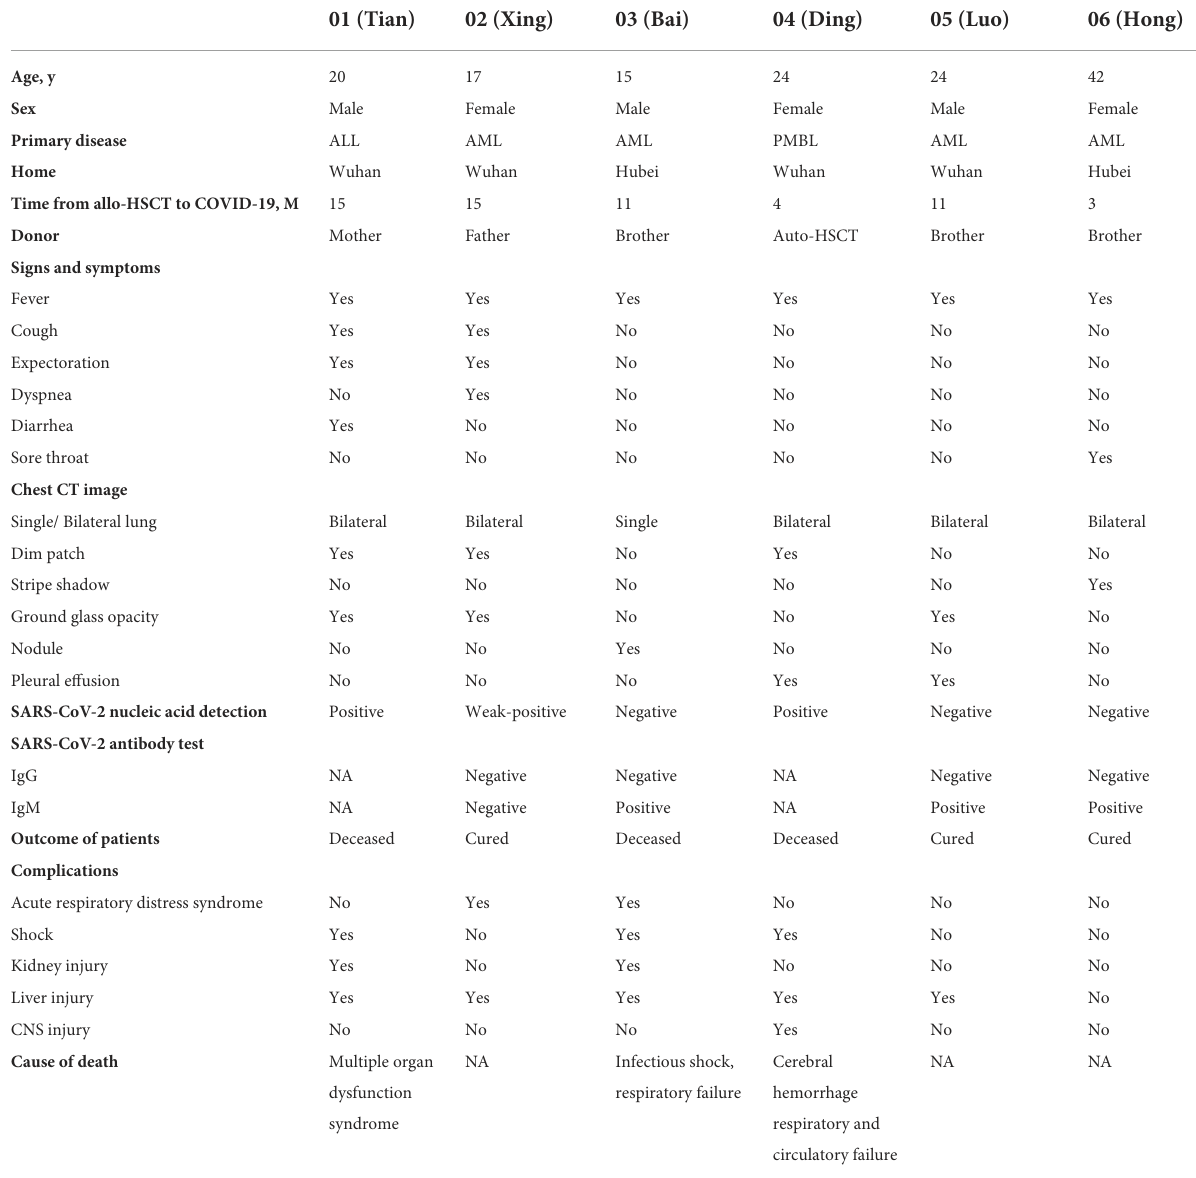
TABLE 4 Characteristics of patients with COVID-19 after HSCT.